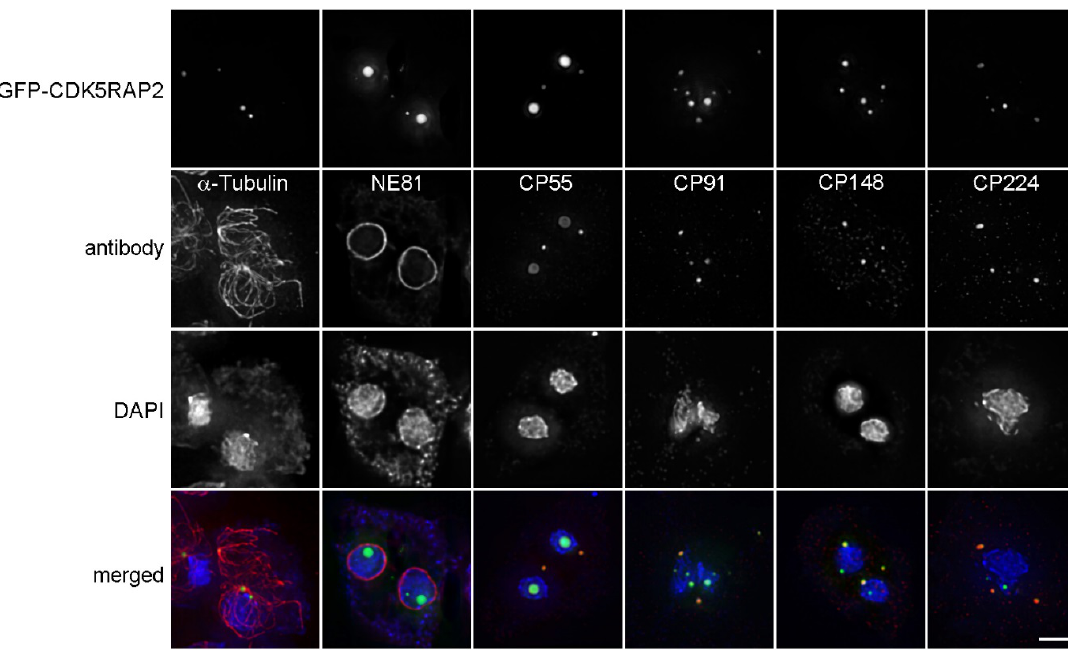
Figure 7. Overexpressed GFP-CDK5RAP2 is concentrated in discrete foci in the cytosol or nucleus. Immunofluorescence microscopy of GFP-CDK5RAP2 cells stained with the indicated antibodies. DNA was stained with DAPI. Secondary anti-rabbit/rat/mouse antibodies were conjugated with AlexaFluor 568. Cells were fixed with methanol. Maximum intensity projections of deconvolved images are displayed, except for the GFP-CDK5RAP2 sample co-stained for NE81 (lamin, nuclear envelope marker, [34]), where only the optical section through the center of the nucleus is shown, to show that there are indeed GFP-CDK5RAP2 foci inside the nucleus. Bar = 2 µm.